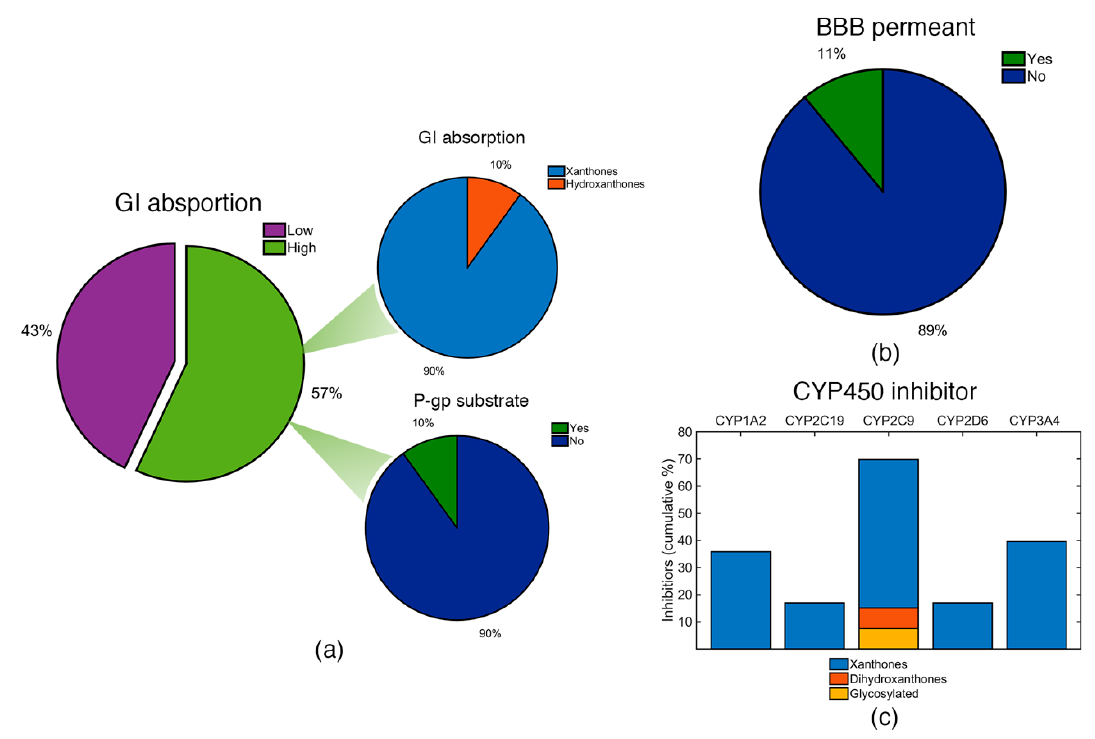
Figure 9. ( a ) GI absorption for the identified marine xanthone derivatives (left pie chart). Marine xanthone derivatives with high GI absorption were classified accordingly to its category (upper pie chart) and as P-gp substrate (lower pie chart). ( b ) BBB permeability of the identified xanthone derivatives. ( c ) Cumulative percentage of compounds identified as inhibitors of the five major isoforms of CYP450.